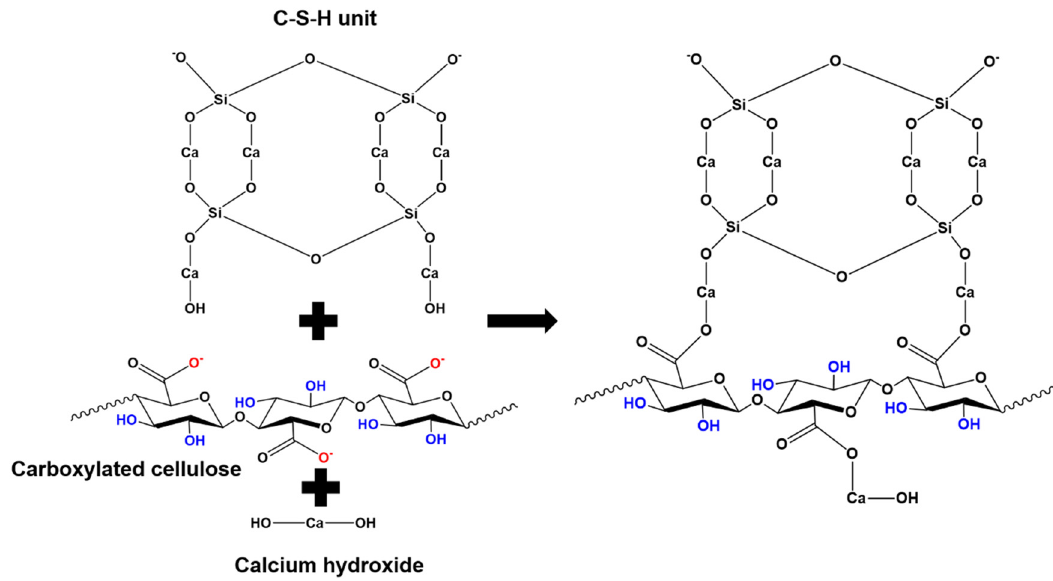
Figure 21: Reaction scheme between carboxylated CNFs and hydration products, including C – S – H and Ca ( OH ) 2 [ 20,140 ]